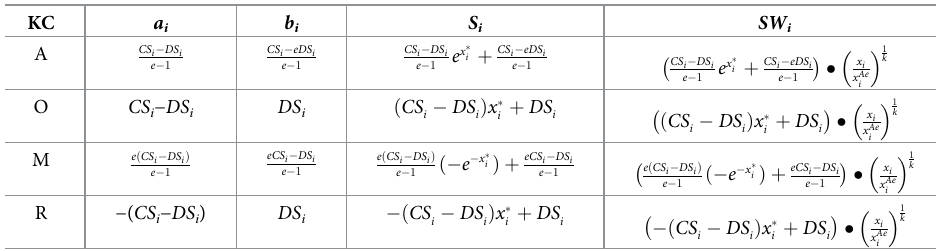
Table 3. Satisfaction function.